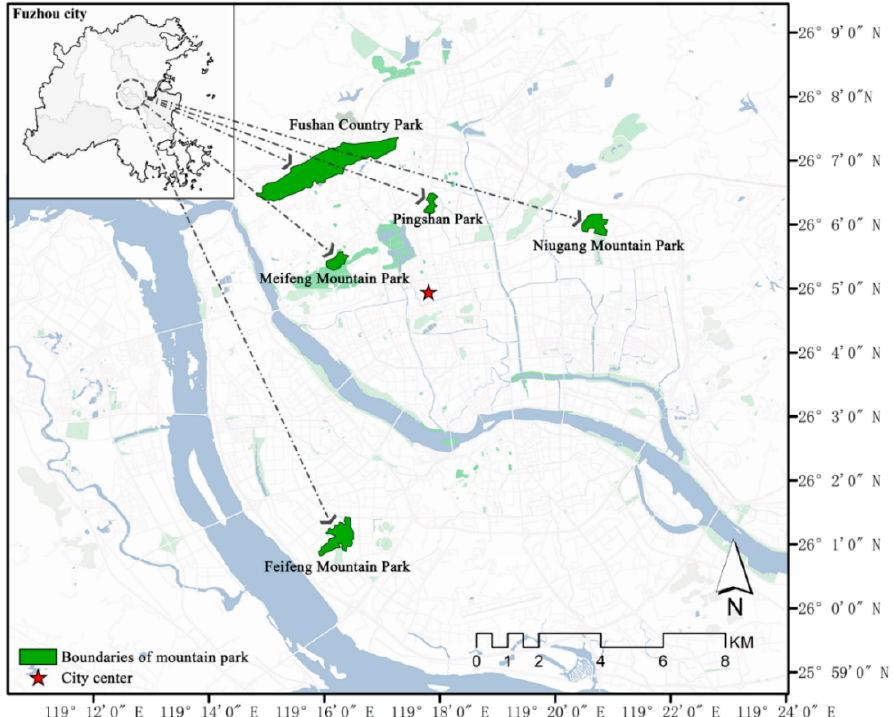
Figure 1. The location map of five urban mountain parks in the subtropical coastal areas of China was selected in this study.